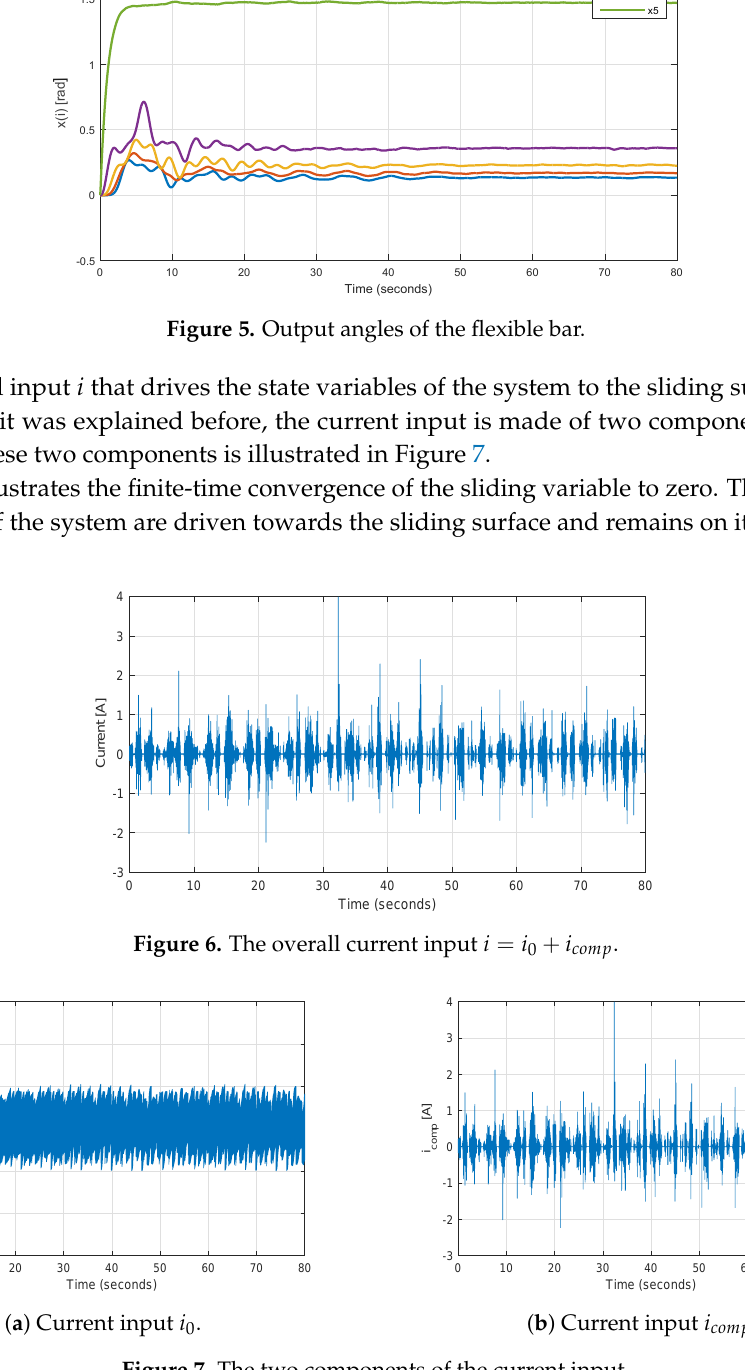
Figure 7. The two components of the current